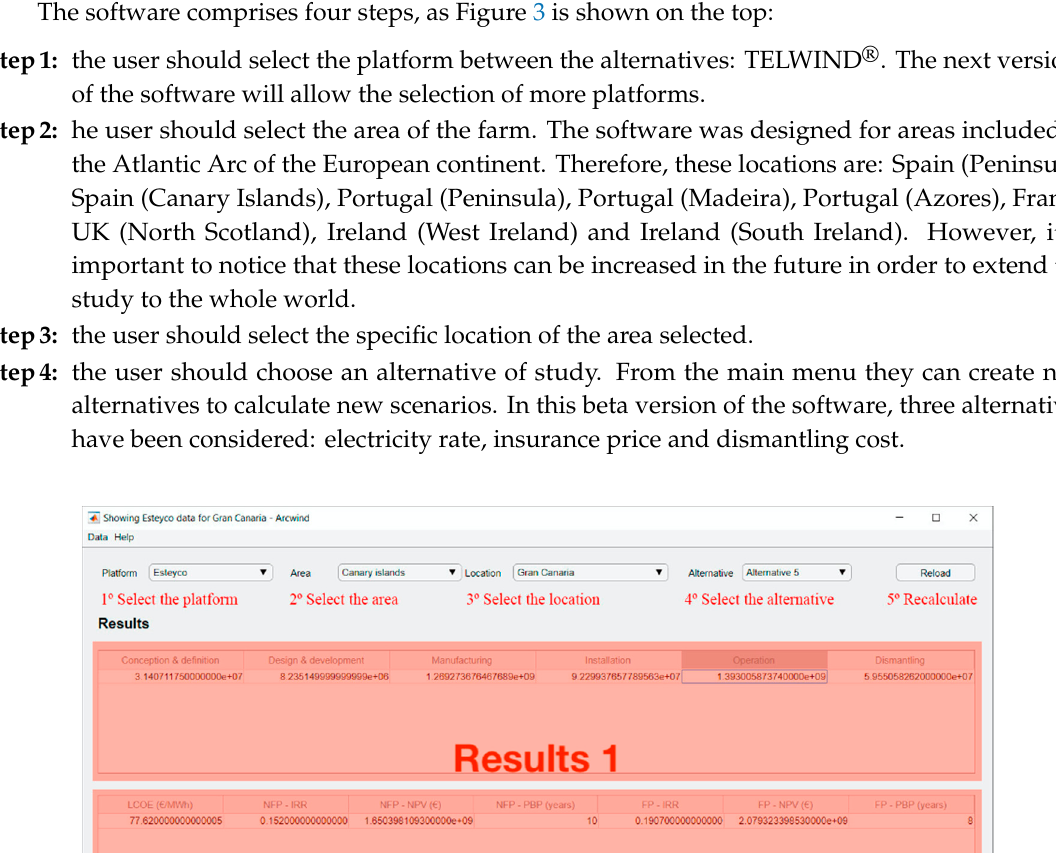
Figure 2. Welcome window.